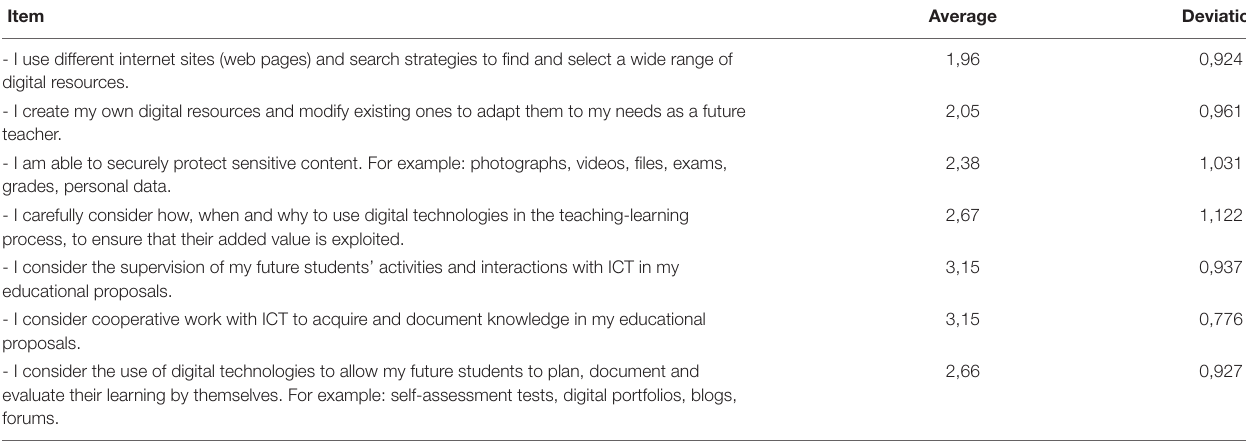
TABLE 4 | Digital teaching competence questionnaire check-in items results (Likert scale 0–4).